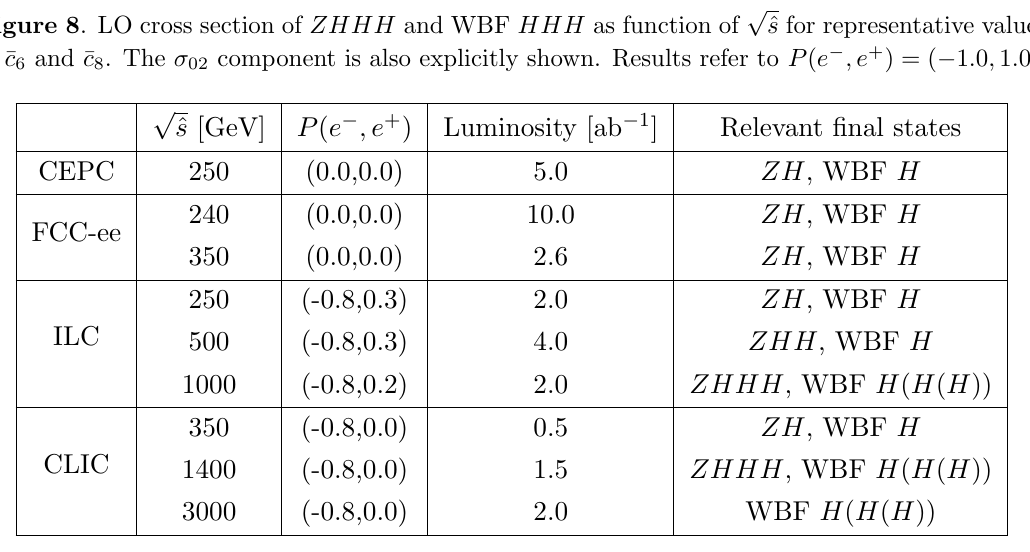
Table 3 . The di(cid:11)erent operation modes for e + e (cid:0) colliders considered in this work. (cid:27) (cid:25) (cid:22) c 4 (cid:27) 40 and in particular (cid:22) LO 6 lower